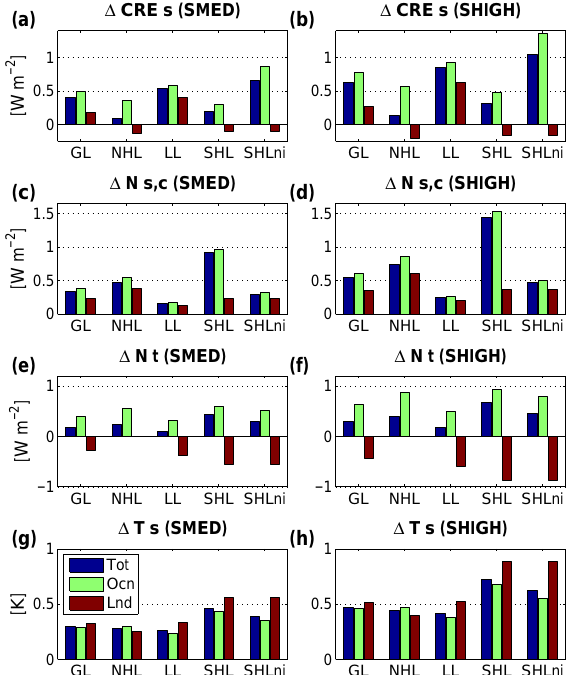
Figure 8. Changes of shortwave cloud radiative effect relative to experiment BASE ( (cid:49) CRE s , Wm − 2 ) for the experiment (a) SMED and (b) SHIGH towards the end of the 22nd century (2171 to 2200). The groups of bars indicate averages over different latitude bands (GL: global; NHL: northern high latitudes, north of 40 ◦ N; LL: low latitudes, 40 ◦ S to 40 ◦ N; SHL: southern high latitudes, south of 40 ◦ S). For the southern high latitudes there is an additional group of bars (SHLni) that indicates averages over the area that is sea- ice-free in the control run. Blue bars indicate the total area average, while green and brown bars indicate averages over ocean and land areas, respectively. (c, d) Same as panels (a) and (b) , but for changes of the top-of-model shortwave net flux under clear sky conditions ( (cid:49)N s , c ). (e, f) Same as panels a and b, but for changes of the top- of-model total net radiative flux ( (cid:49)N t ). (g, h) Same as panels a and b, but for changes of surface temperature ( (cid:49)T s